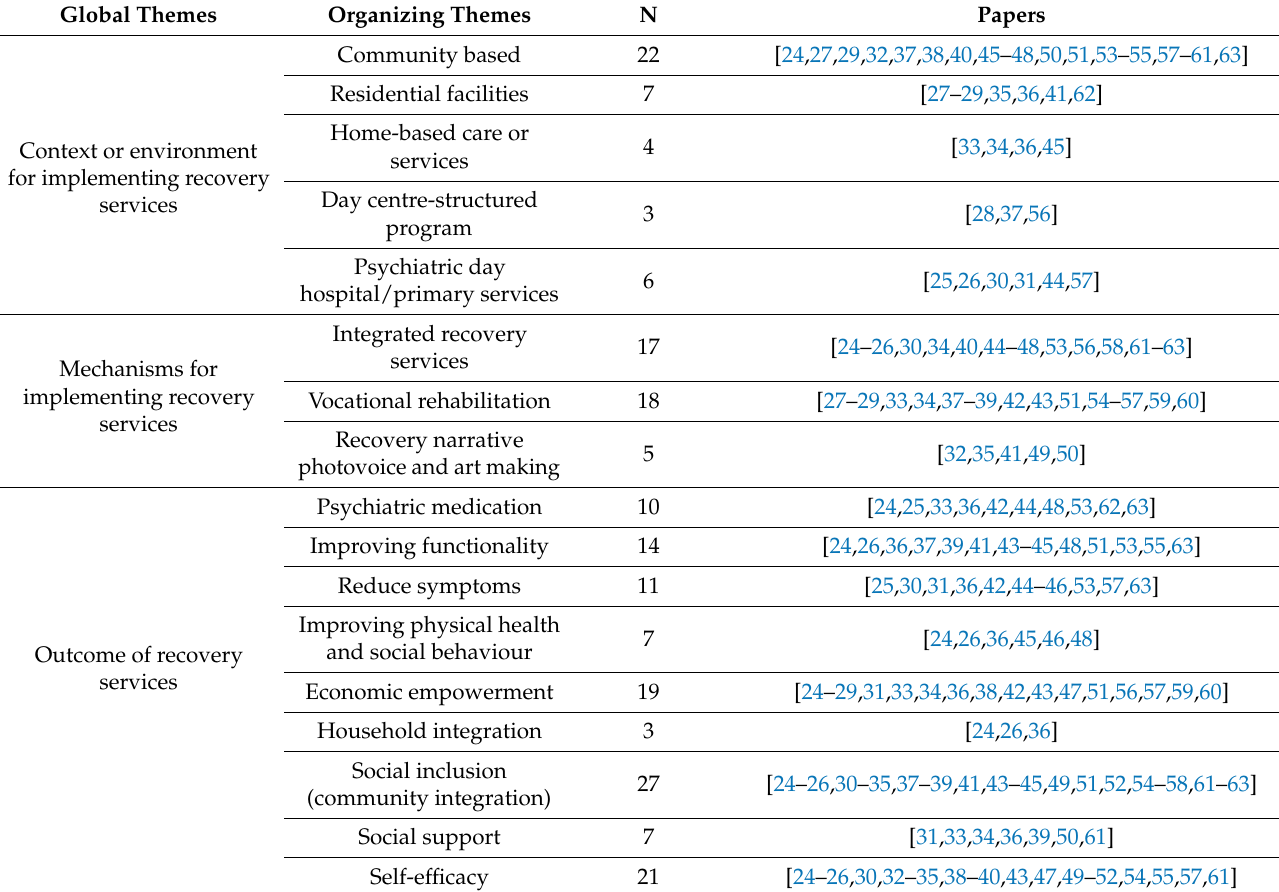
Table 3. Themes identified from mixed-methods